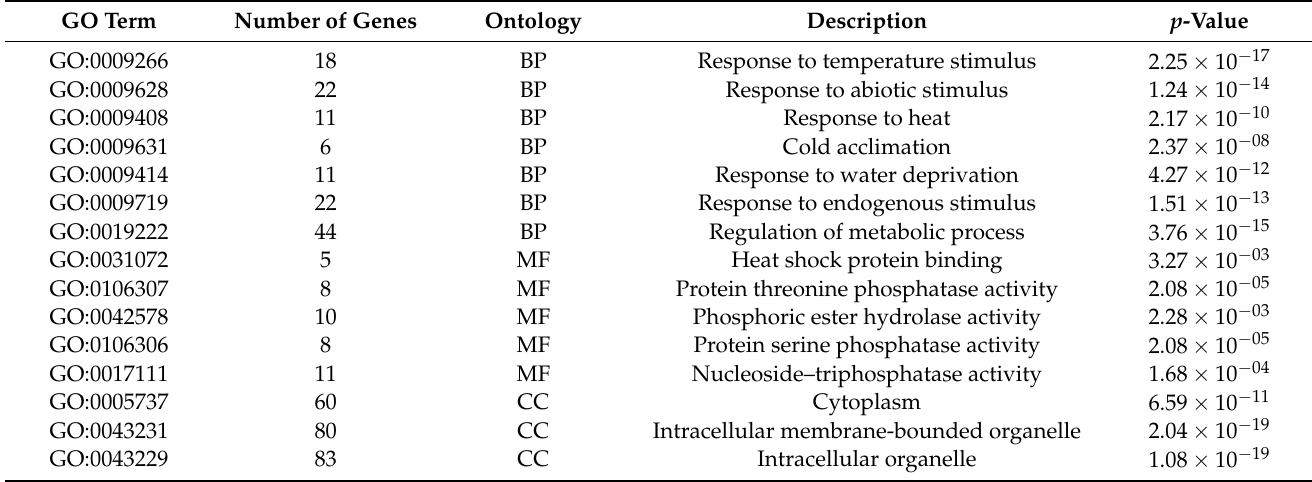
Figure 3. Prediction performance of the RWR on the multiplex network and the PPI network. Table 1. Results of the enrichment